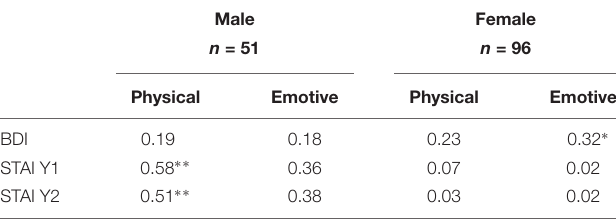
TABLE 4 | Correlation between the number of physical and emotional symptoms reported by male and female HCP victims of stalking and domestic violence and depressive and anxiety symptoms ( N = 147).